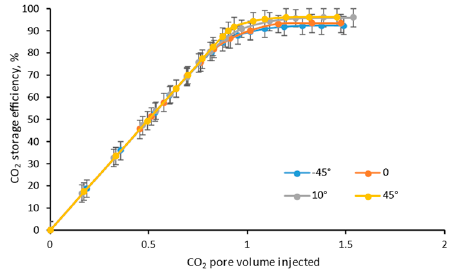
Figure 14. Relation curves between long core CO 2 storage efficiency and injection volume under different dip angles.